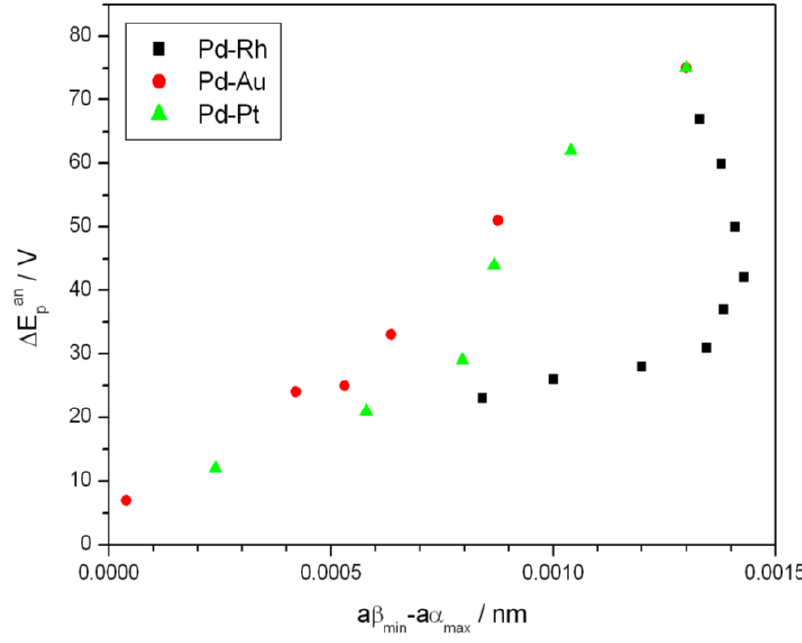
Figure 11. Correlation of the difference between minimum value of the potential of anodic peak 2 just before the phase transition and its final value at low electrosorption potentials (ΔE pan ) with the difference in lattice constants for α- and β-phase boundaries taken from the literature [37,38] for various alloys at 298